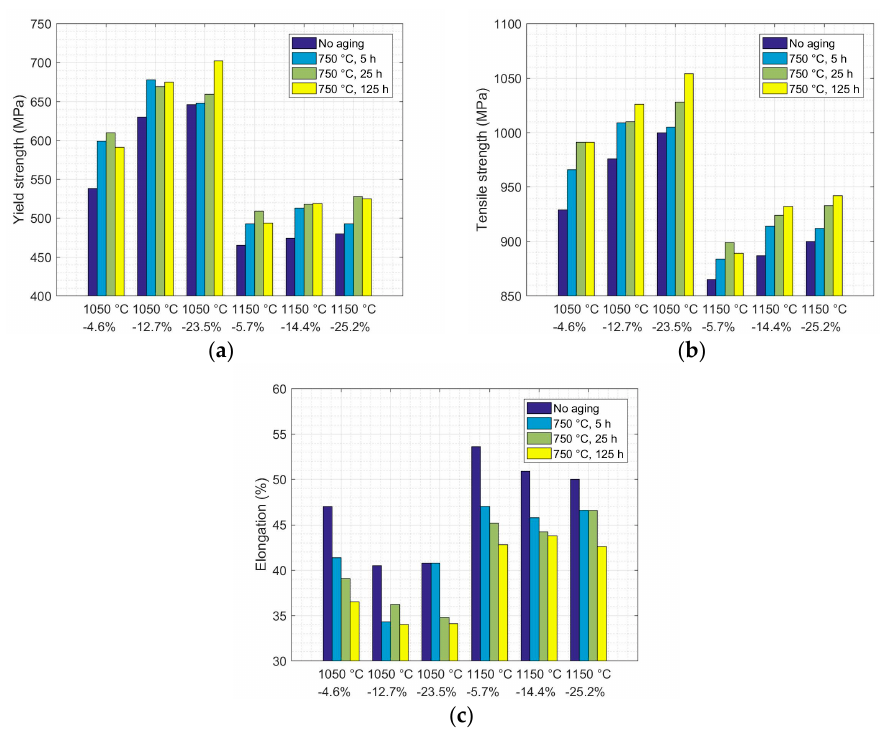
Figure 17. The yield strength ( a ), tensile strength ( b ) and elongation ( c ) for the samples with prior deformation at 1050 and 1150 ◦ C unaged and aged at 750 ◦ C for 5, 25 and 125 h. Most of the samples had a ductile fracture surface after the tensile test (Figures 18–20). The fracture surface of the tensile-test specimens revealed cracks and particle pull outs. The cracks and pull-outs were seen even in the unaged samples (Figure 18a,b). The cracks originated at segregation bands, due to the primary NbC carbides, the (Nb,Ti)(C,N) carbo nitrides and the TiN nitrides (Figure 20a,b). A cross-section of tensile-test specimens revealed pores in lines. Some pores contained shattered particles (Figure 20b). During the tensile tests, pores formed in the segregation bands, and were connected to each other, thus forming a crack during fracture. After aging, the cracks grew in size and depth, due to the extensive precipitation in the segregation bands (Figure 13d). The hot- rolled sample at 1150 °C, with the deformation level of 5.7% and aged at 750 °C for 5+ h, had an inter- crystalline fracture (Figure 21) due to the precipitation of secondary M 23 C 6 carbides (Figure 8b).